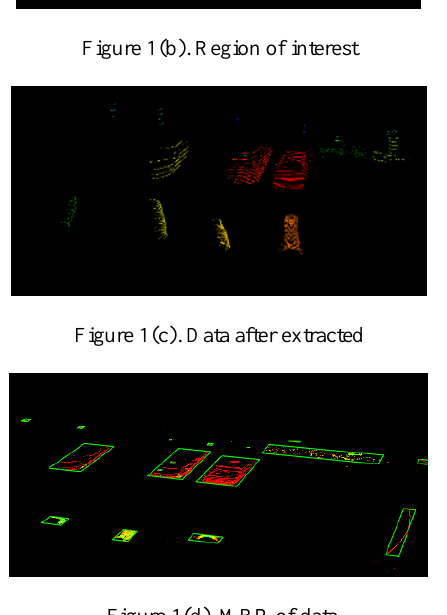
Figure 1(d). MBR of data